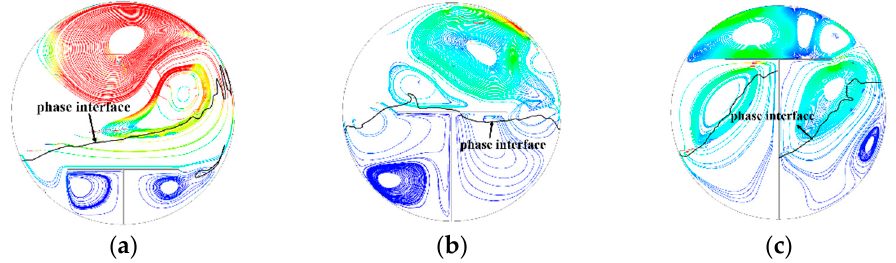
Figure 16. Flow diagram with T-shaped baffle vs. non-baffle (LR = 50%, t = 1 s). ( a ) non-baffle; ( b ) baffle with HR = 0.5.